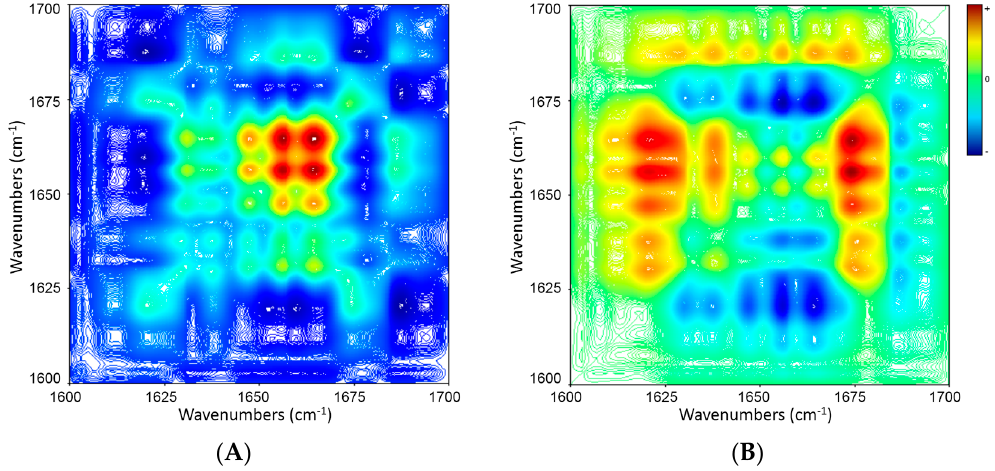
Figure 7. 2D IR synchronous ( A ) and asynchronous ( B ) maps of amide I bands of PSCs (5% w / v in D 2 O) during heating (5 → 70 °C, in increment of 5 °C). Red and blue color represent positive and negative correlation peaks, respectively.